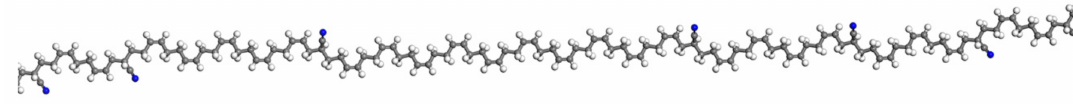
Figure 2. The chemical structure of the nitrile rubber molecule chain.